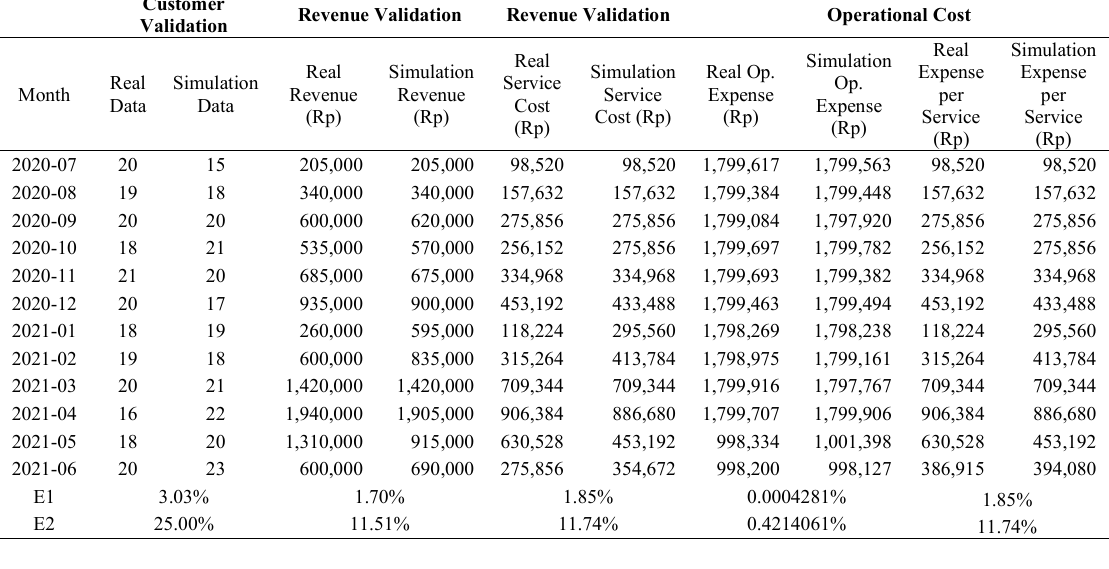
TABLE 2 C USTOMER . C OST , E XPENSE , AND R EVENUE V ALIDATION